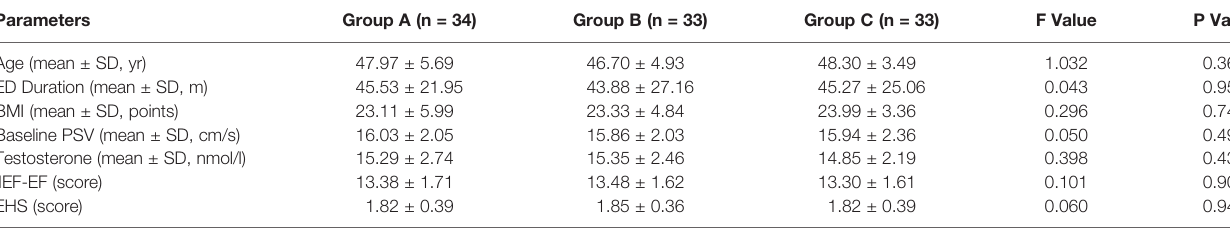
TABLE 1 | Baseline characteristics of patients with diabetic erectile dysfunction in three groups.